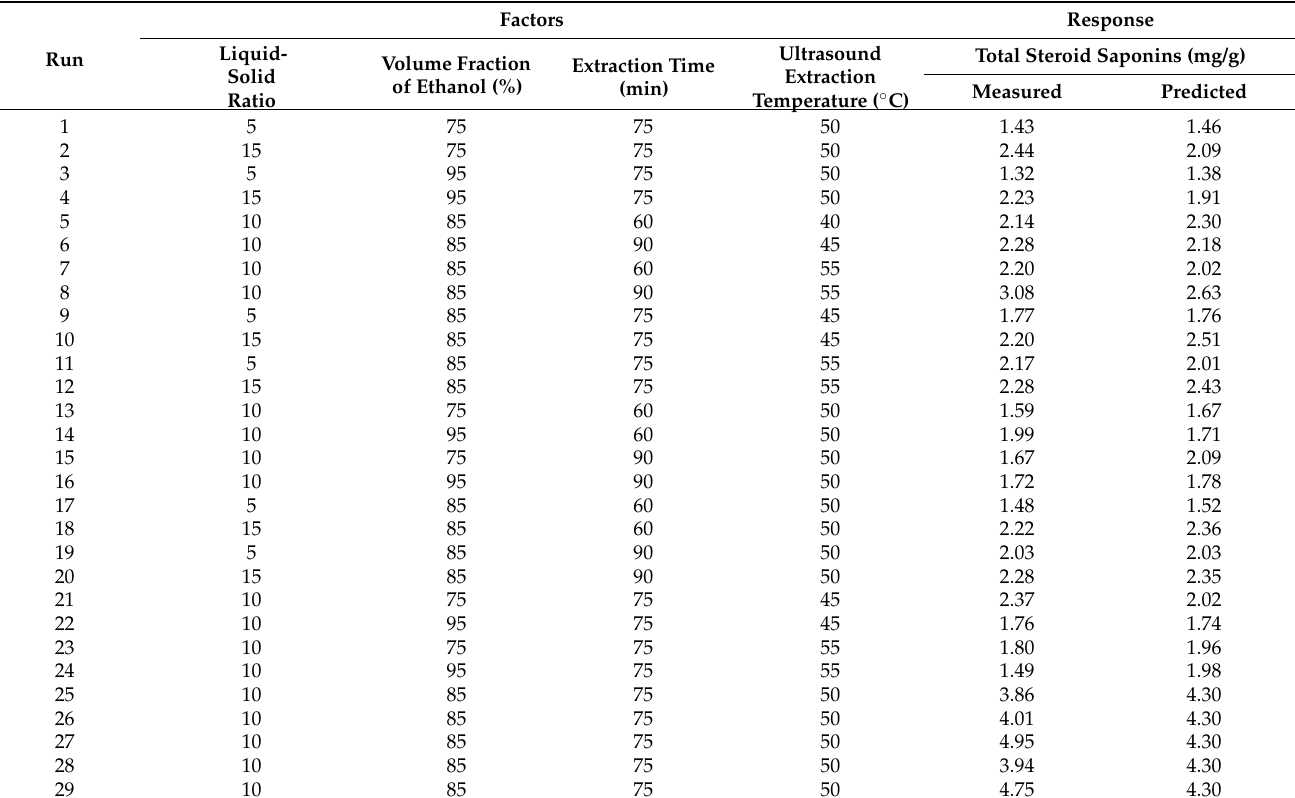
Table 1. Box–Behnken design matrix with coded variables and measured and predicted values.